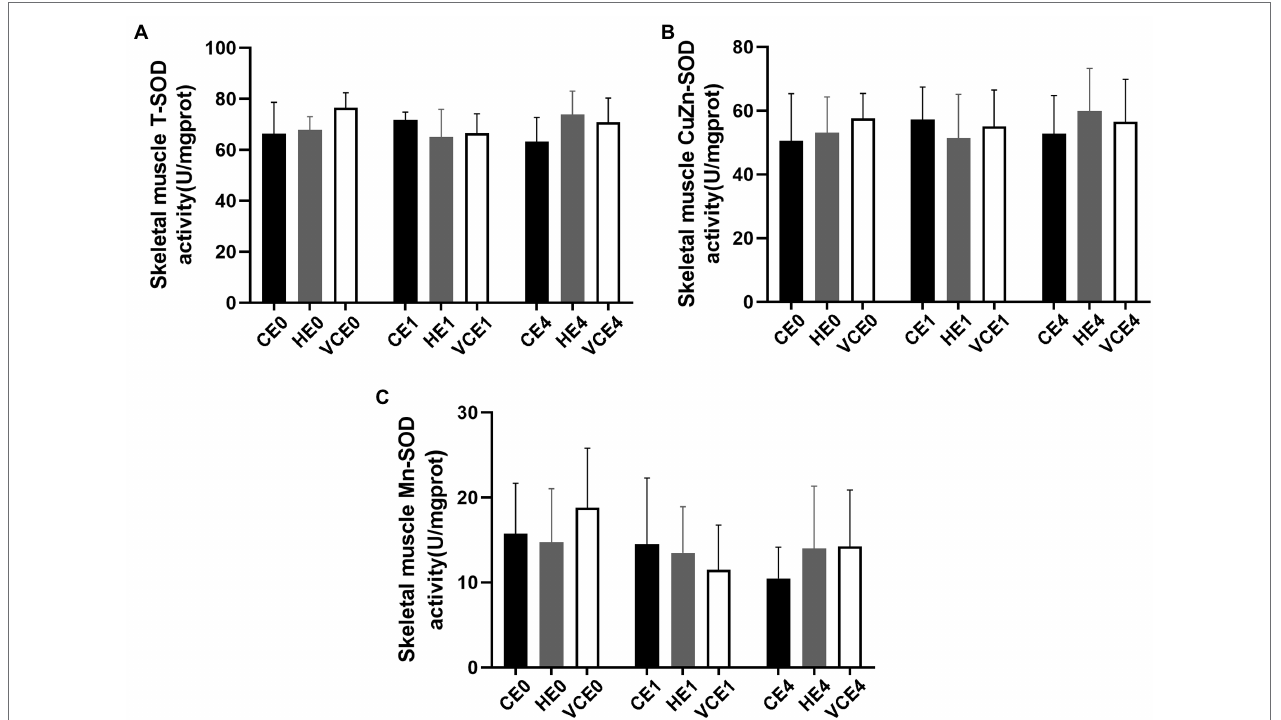
FIGURE 5 | Total SOD (T-SOD) activity (A) and CuZn-SOD activity (B) in gastrocnemius muscle of each group, and Mn-SOD activity (C) was calculated according to their subtraction. C, blank control; H, inhalation of hydrogen gas; VC, vitamin C supplementation; E0, baseline; E1, immediately after exercise; and E4, 4 h after exercise. n = 8 per